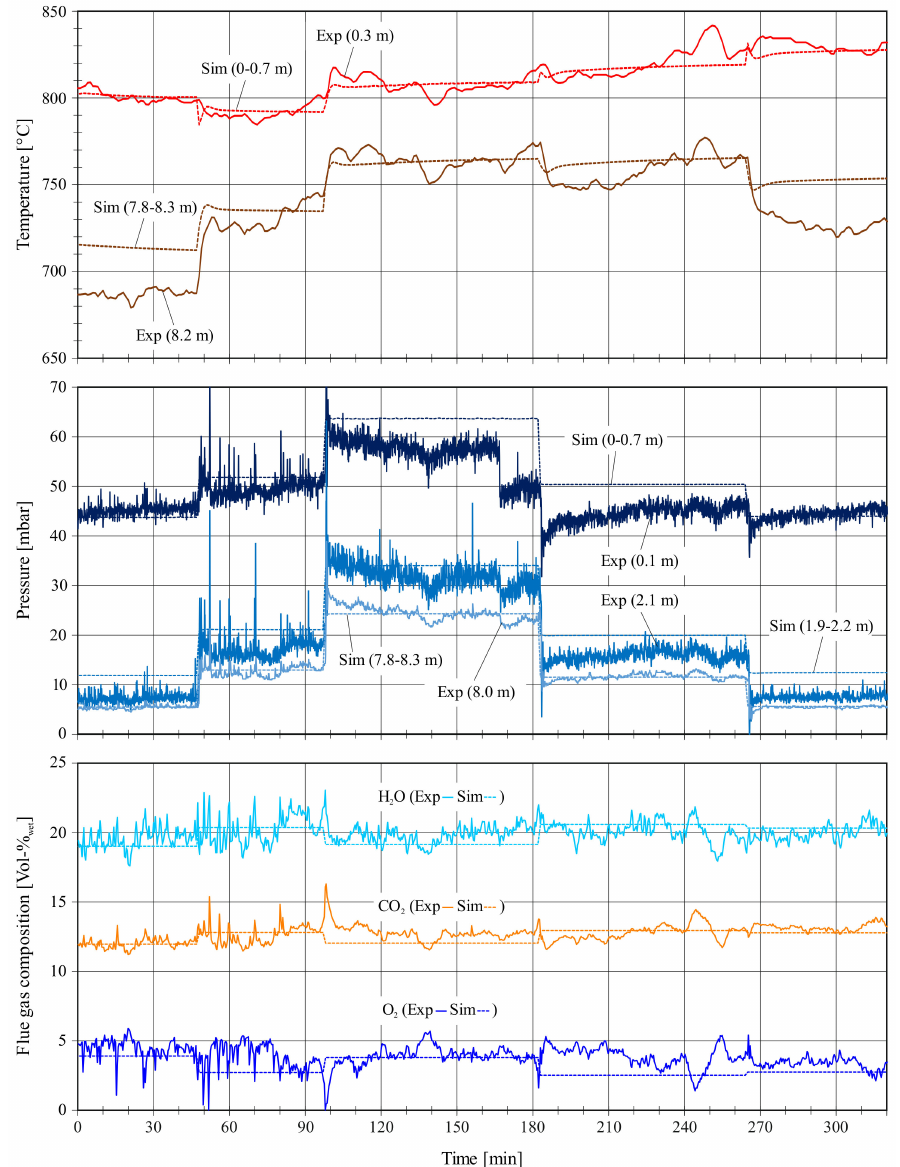
Figure 12. Temperature, pressure, and fuel mass flow during load change